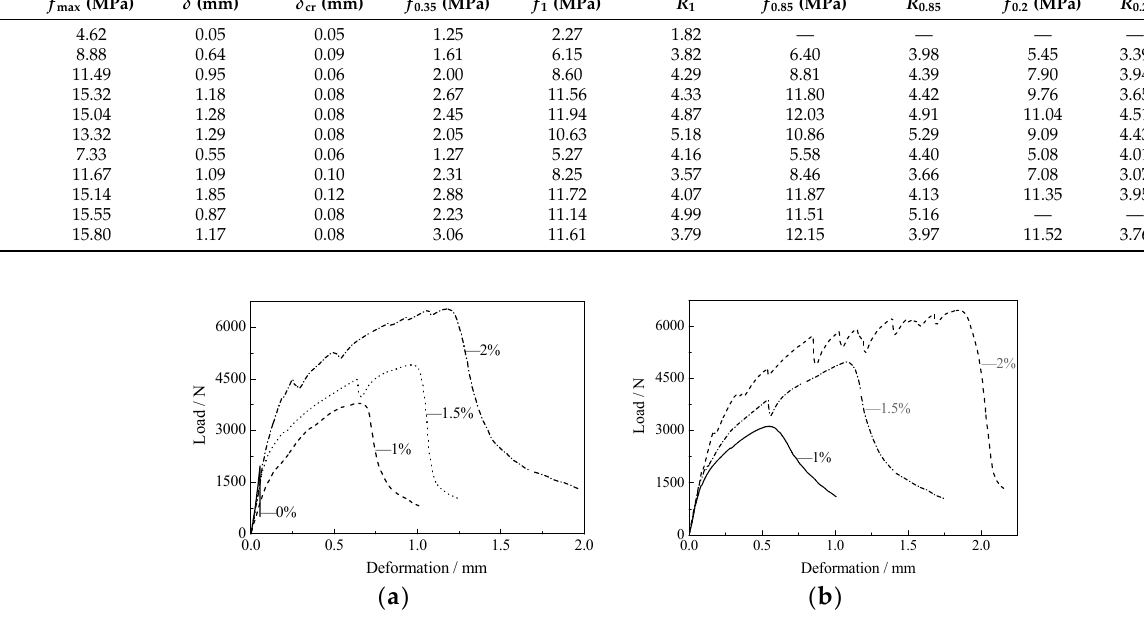
Table 3. Test results and flexural toughness indexes of specimens.